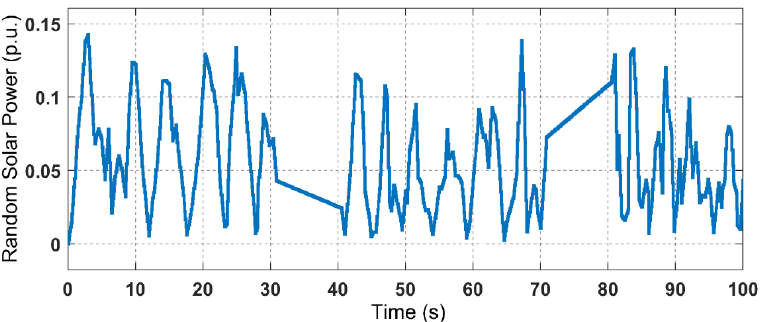
Figure 13. Dynamic response of the multi-area power system at a random change load: ( a ) The frequency deviation of area 1; ( b ) The frequency deviation of area 2; ( c ) The power deviation of the tie line.